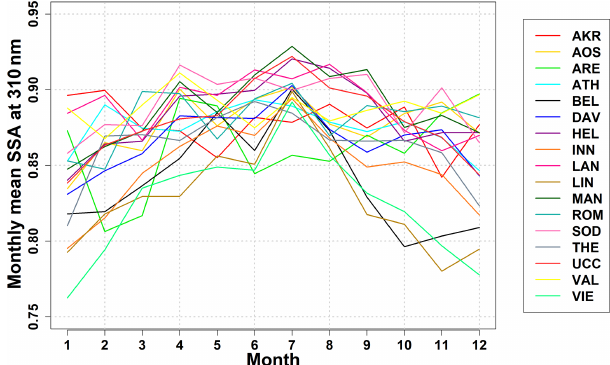
Figure 9. The monthly mean (i.e., 1–12 = January–December) SSA levels for all ground stations as derived by the MACv2 database.